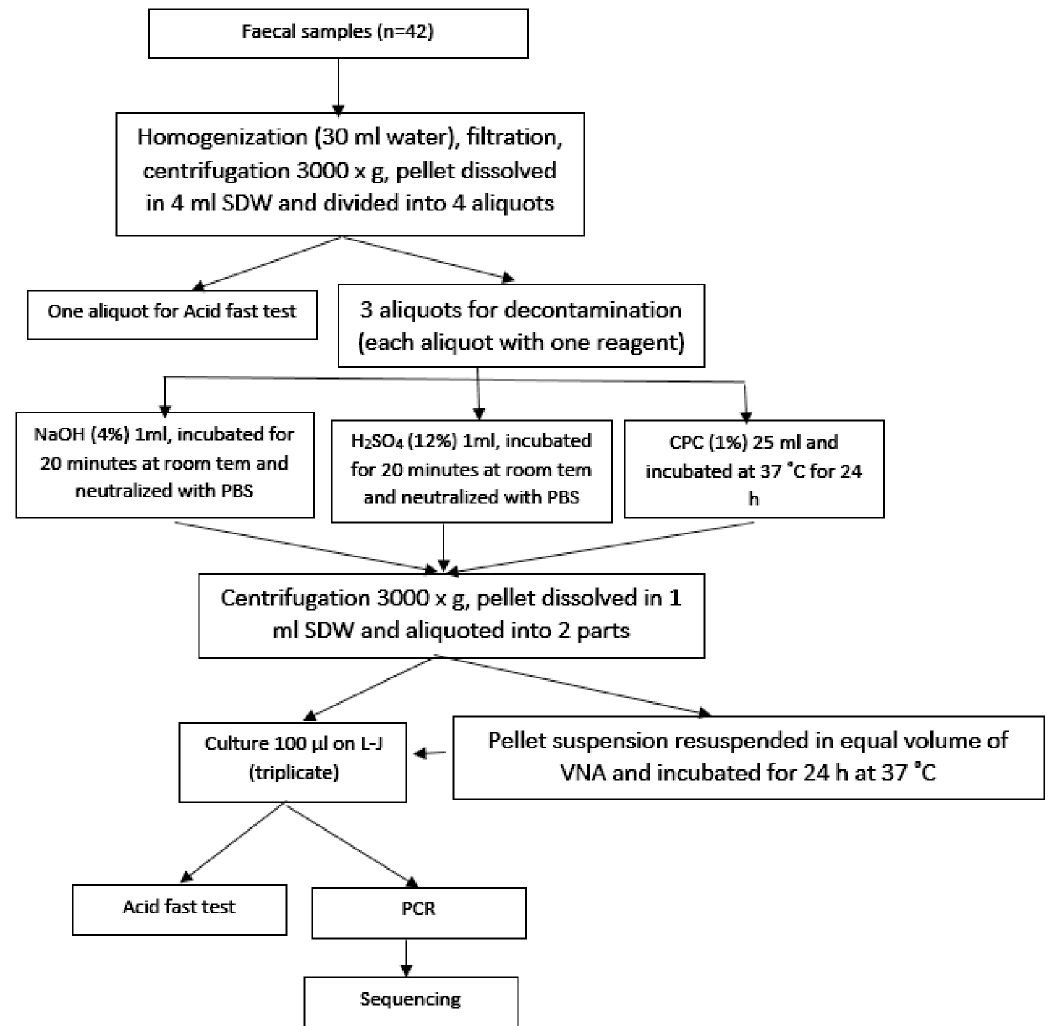
Fig 2. Schematic illustration for fresh fecal samples preparation and decontamination with six procedures.